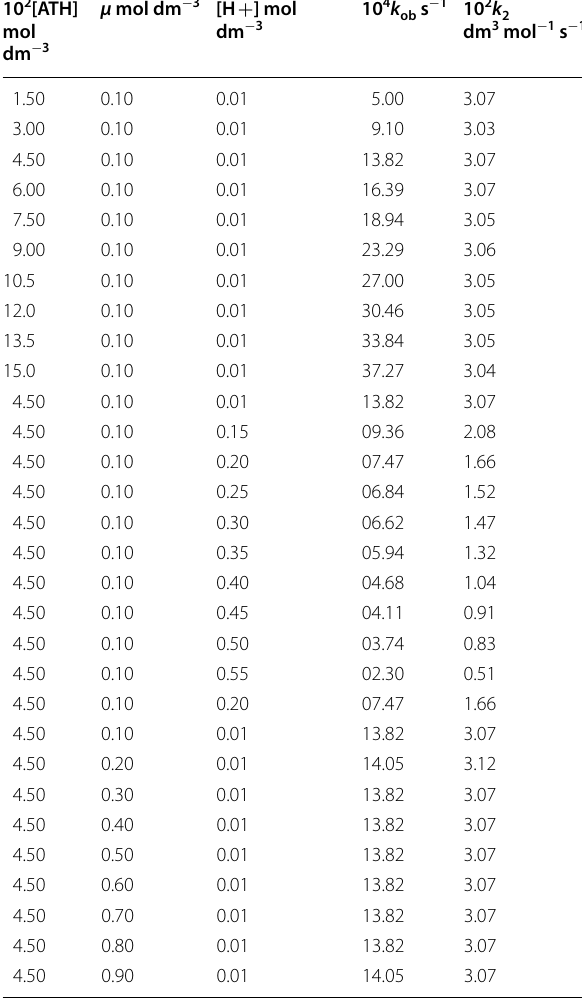
Table 1 Pseudo-first-order and second-order rate constants for the reaction of [Mo IV O D 77.9, λ 560 nm, and T max = =